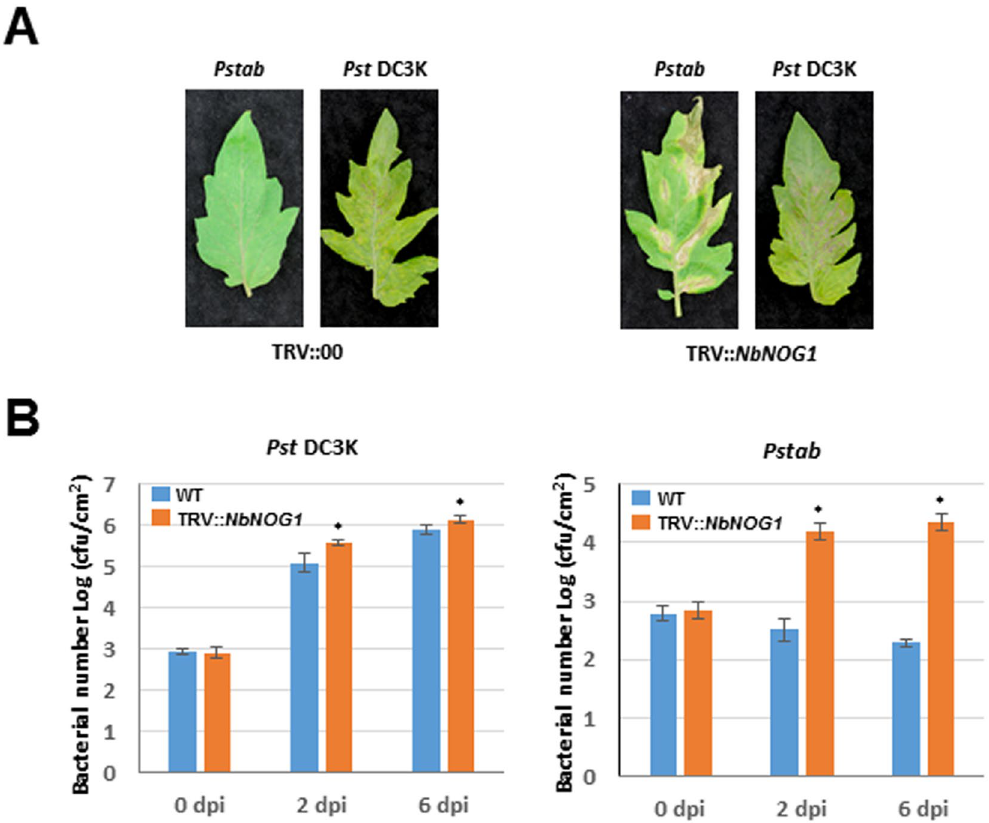
Figure 2. Tomato SlNOG1– silenced plants are compromised in nonhost resistance. ( A ) SlNOG1 -silenced tomato compromised nonhost resistance. TRV:: NbNOG1 and TRV::00 inoculated tomato plants were sprayed with the nonhost pathogen P . syringae pv. tabaci ( Pstab ) and the host pathogen P . syringae pv. tomato DC3000 ( Pst DC3K). Pictures were taken after 5 days after inoculation. ( B ) The bacterial growth of both pathogens was significantly higher in SlNOG1 -silenced plants than TRV::00 plants. Bacterial growth was measured after 2 and 6 dpi. Bars represent means and standard deviation for three independent experiments. Asterisks represent statistically significant difference between treatments for equivalent time points using Student’s t - test ( P <